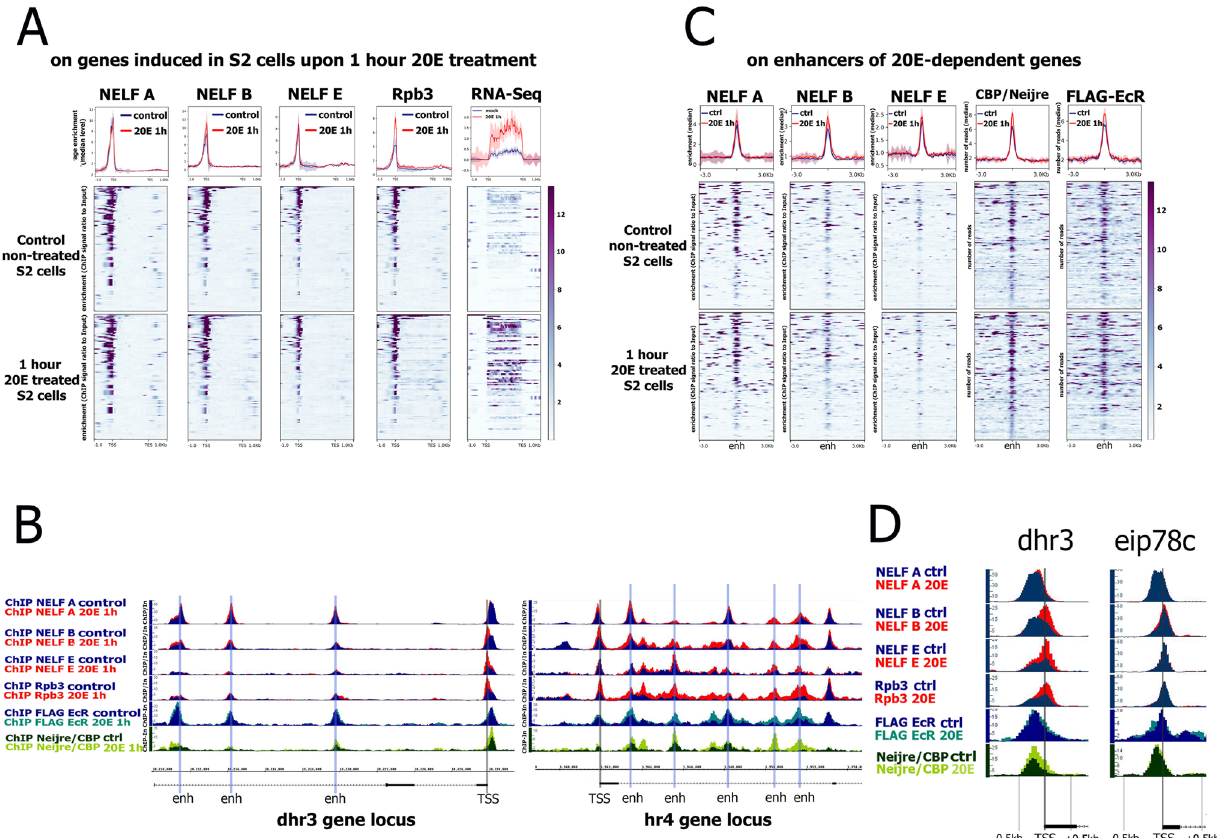
Figure 2. NELF complex subunits colocalize with promoters and enhancers of 20E-dependent genes. ( A ) Average distribution of NELF-A, NELF-B, NELF-E (NELF subunits) and Rpb3 (Pol II subunit) binding and an average of RNA-seq signal on 20E -dependent genes upon 1 h 20E treatment (20E 1 h) and in DMSO- treated (Control) Drosophila S2 cells. The list of 20E-dependent genes induced in Drosophila S2 cells upon 1 h 20E treatment was estimated in a previous study 1 . NELF-A, NELF-B, NELF-E and Rpb3 binding levels were calculated as an enrichment (ratio of corresponding ChIP-Seq signal over input DNA). Average profiles were generated using metagene mode (introns were ignored) and calculated as a median of NELF-A, NELF-B, NELF-E and Rpb3 binding level and RNA-seq signal, respectively. The standard error is displayed on the graphs as lighter area around the main line of the profiles. ( B ) Binding profiles of NELF-A, NELF-B, NELF-E, Rpb3, FLAG-EcR and CBP/Neijre at dhr3 , hr4 20E-inducible genes. Grey lines indicate TSSs and enhancers (enh). Protein binding levels were estimated by ChIP-Seq. ChIP-Seq experiments were performed using 1 h 20E- or DMSO-treated Drosophila S2 cells (which is indicated on the left of the figure as 20E 1 h and Control, respectively). ChIP-Seq data on FLAG-EcR binding were loaded from GSE139316 and described previously in ref. 3 . ( C ) Average distribution of NELF-A, NELF-B, NELF-E, CBP/Neijre (GSE156847) and FLAG-EcR (GSE139316) on enhancers of 20E-dependent genes upon 1 h 20E treatment (20E 1 h) and in DMSO-treated (Control) Drosophila S2 cells. NELF-A, NELF-B, NELF-E binding levels were calculated as an enrichment (ratio of corresponding ChIP-Seq signal over input DNA). CBP/Neijre and FLAG-EcR binding levels were calculated as difference between ChIP-Seq signal and Input. Pile-up profiles were calculated as a median of protein binding levels. The standard error is displayed on the graphs as lighter area around the main line of the profiles. ( D ) Binding profiles of NELF-A, NELF-B, NELF-E, Rpb3, FLAG-EcR and CBP/Neijre at TSSs of dhr3 and eip78c 20E-inducible genes. Protein binding levels were estimated by ChIP-Seq. ChIP-Seq experiments were performed using 1 h 20E- or DMSO-treated Drosophila S2 cells (which is indicated on the left of the figure as 20E 1 h and Control, respectively). ChIP-Seq data on FLAG-EcR binding were obtained previously 3